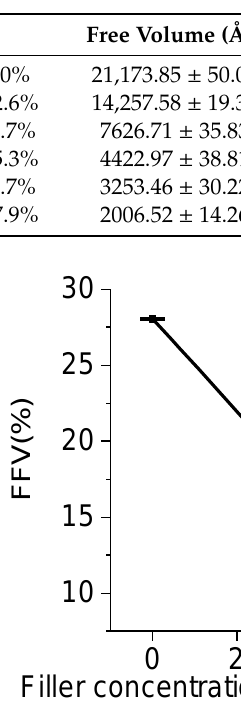
Table 2. Fractional free volume of PUF-SiO 2 models (mean ± standard error).